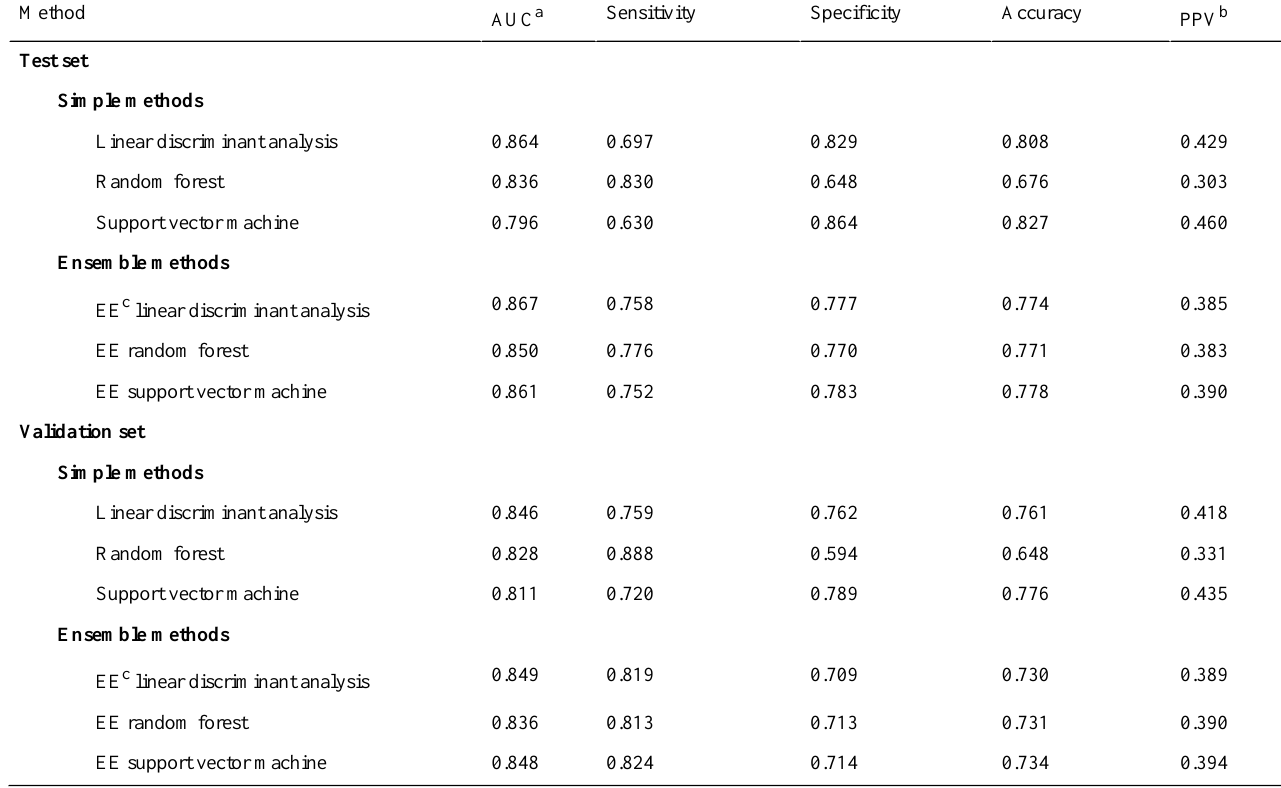
Table 3. Performance of the simple and ensemble methods in the text and validation